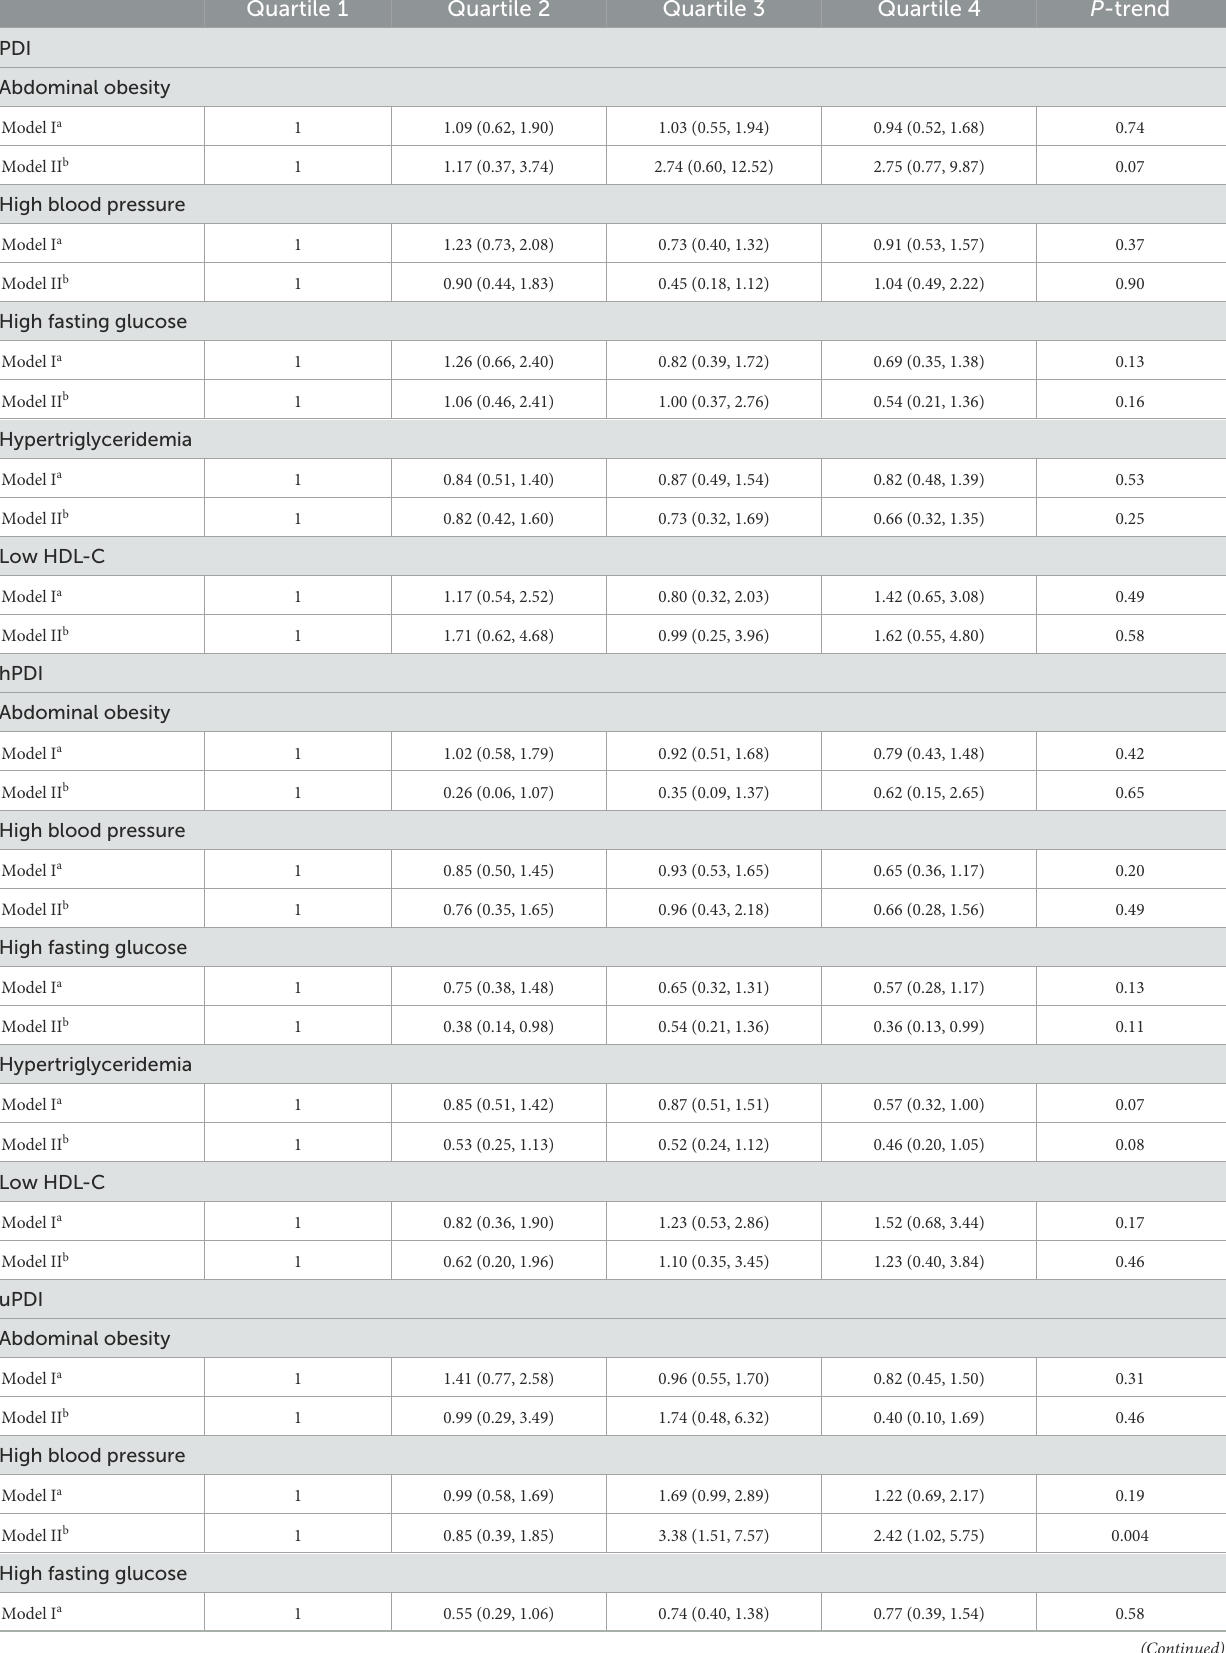
TABLE 3 Multivariate adjusted odds ratio (OR) and 95% confidence interval (CI) for the association of energy-adjusted plant-based diets with components of metabolic syndrome. Quartile 1 Quartile 2 Quartile 3 Quartile 4 P